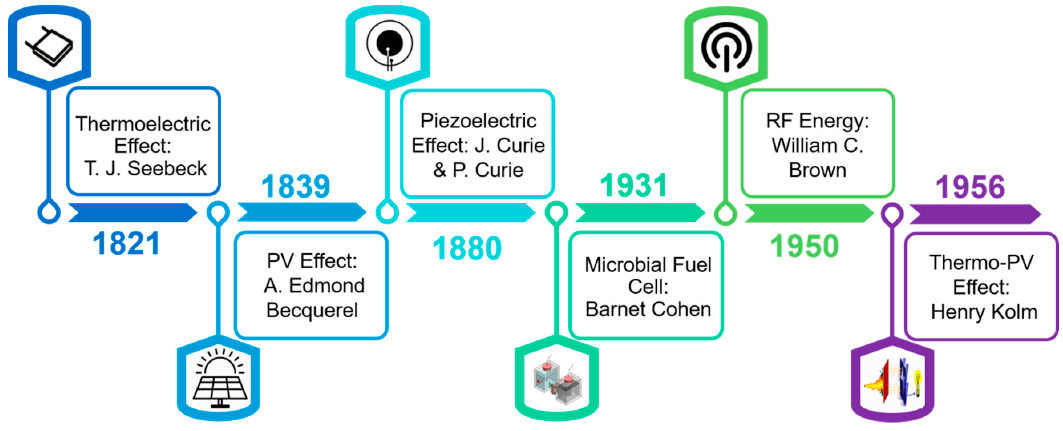
Figure 2. Basic energy harvesting (EH) timeline (1821–1956) [53,60,62].